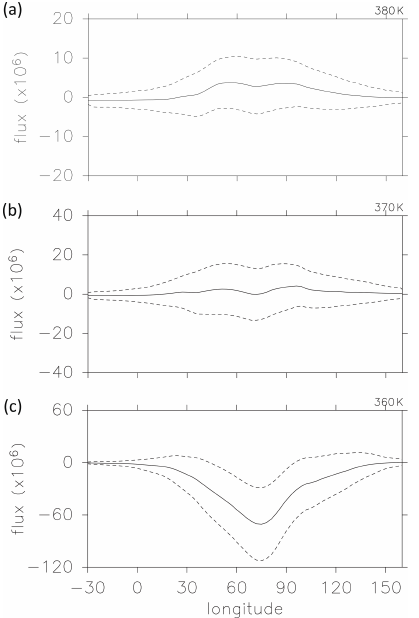
Figure 3. Climatological mean zonal flux of the thickness-weighted low-PV area as a function of longitude, calculated at the (a) 380K, (b) 370K, and (c) 360K isentropic levels. The unit of the flux is kilograms per kelvin per second (kgK − 1 s − 1 ). Solid and broken curves correspond to mean values and ranges of standard